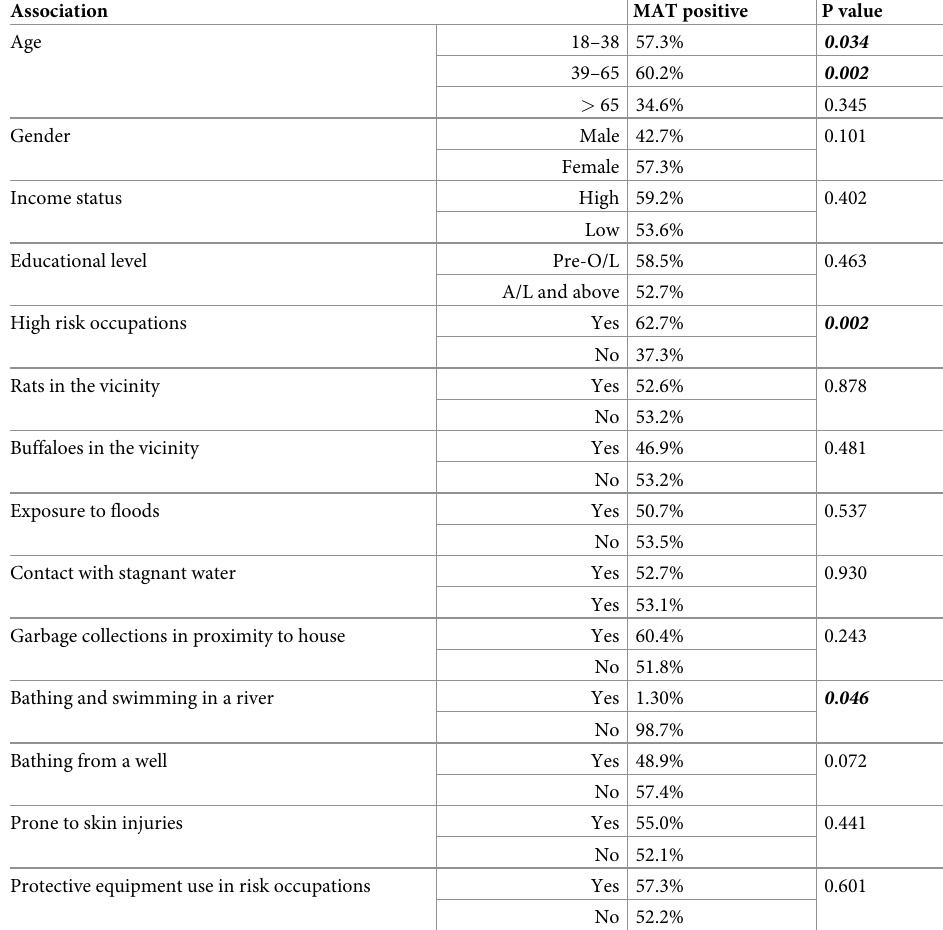
Table 5. Associations of non-pathogenic MAT